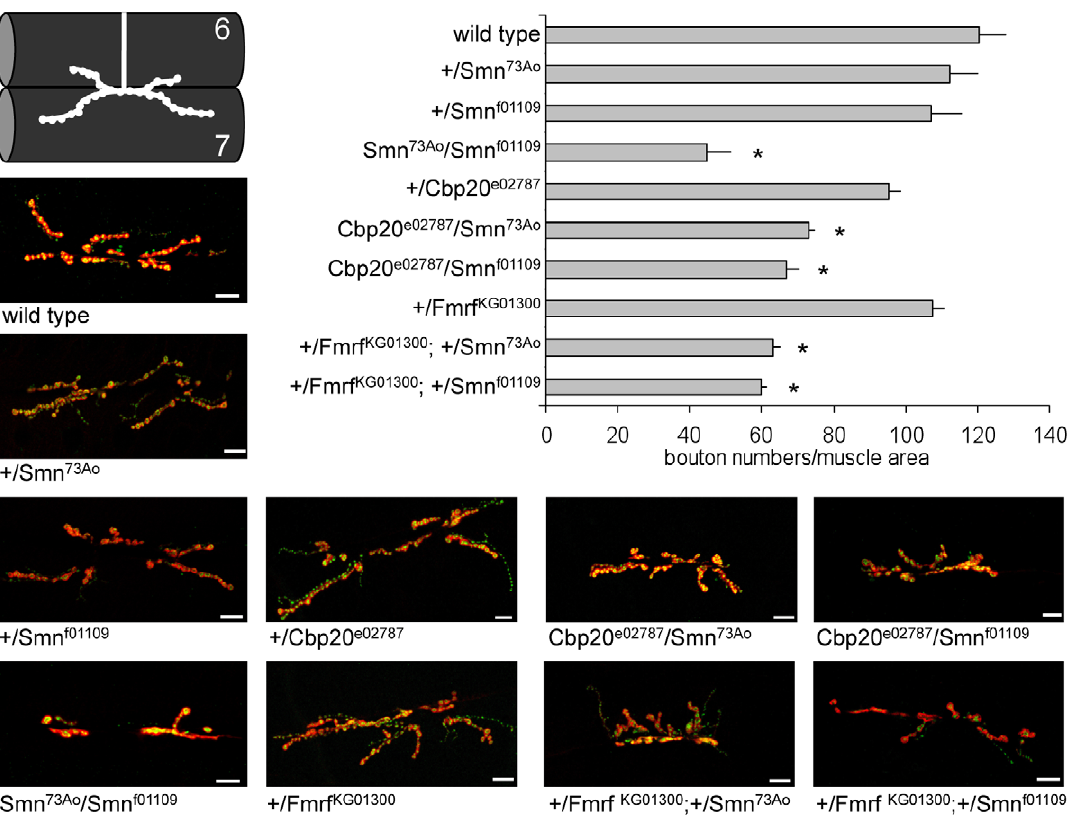
Figure 6. Loss of Drosophila Cbp20 or FMRF enhances Dm Smn loss of function neuromuscular defects. For two C. elegans modifier genes, loss of function alleles were available for orthologous Drosophila genes: Cbp20 and FMRF [68–70]. Loss of either Drosophila gene enhanced the NMJ defects of Dm Smn animals. The number of synaptic boutons in the A2 segment of muscles 6 and 7 was counted in third instar larvae (visualized using Discs large and synaptotagmin immunoreactivity, shown in red and green, respectively). Homozygous loss of Dm Smn in Dm Smn f1109 / Dm Smn 73Ao animals dramatically decreases bouton number but loss of one copy of Dm Smn, Cbp20 or FMRF had little effect. Loss of one copy of either Cbp20 or FMRF in animals heterozygous for either Dm Smn allele significantly decreased bouton numbers. This nonallelic noncomplementation suggests a strong genetic interaction between these two conserved modifier genes and Dm Smn. Scale bar indicates 10 microns in representative images; S.E.M. is shown in graph; all transheterozygous combinations are significantly different from the corresponding single heterozygous controls with p # 0.05 by ANOVA as indicated with asterisk.